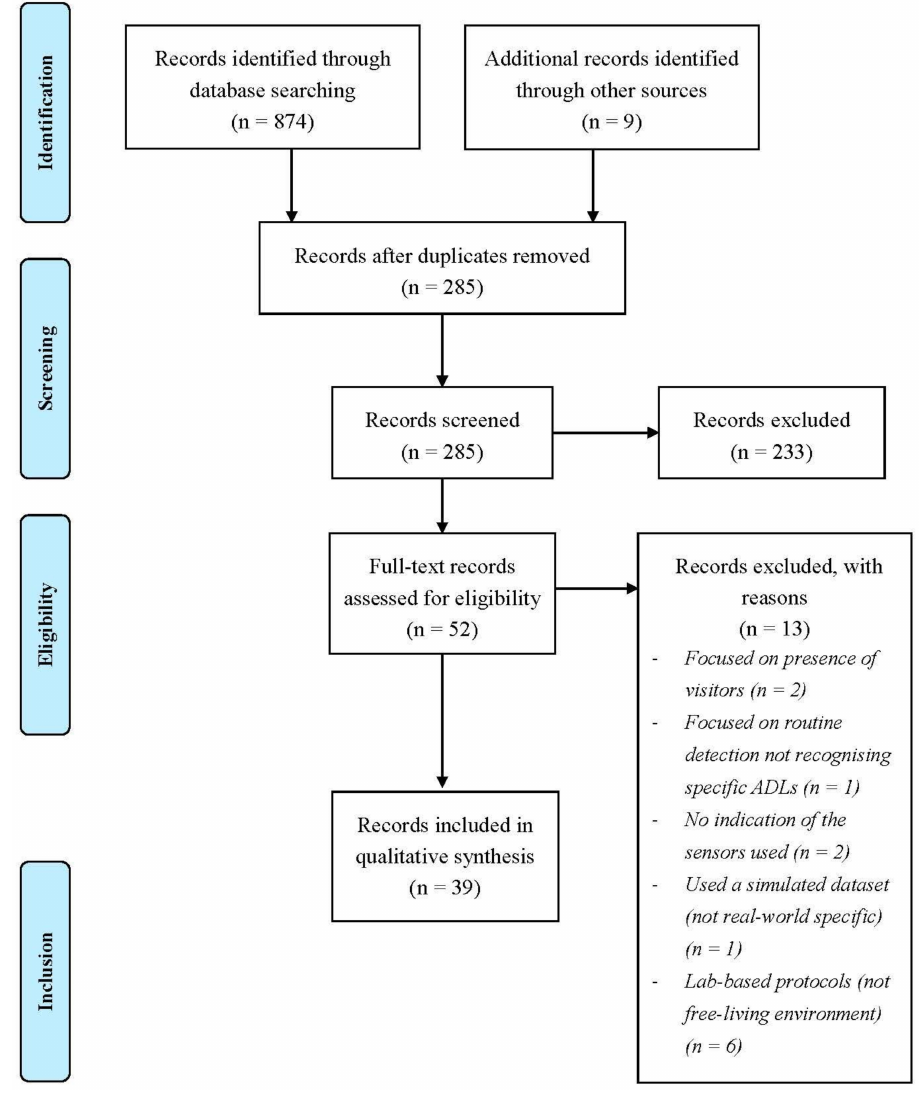
Figure 1. PRISMA paper selection flowchart, adapted from [32].